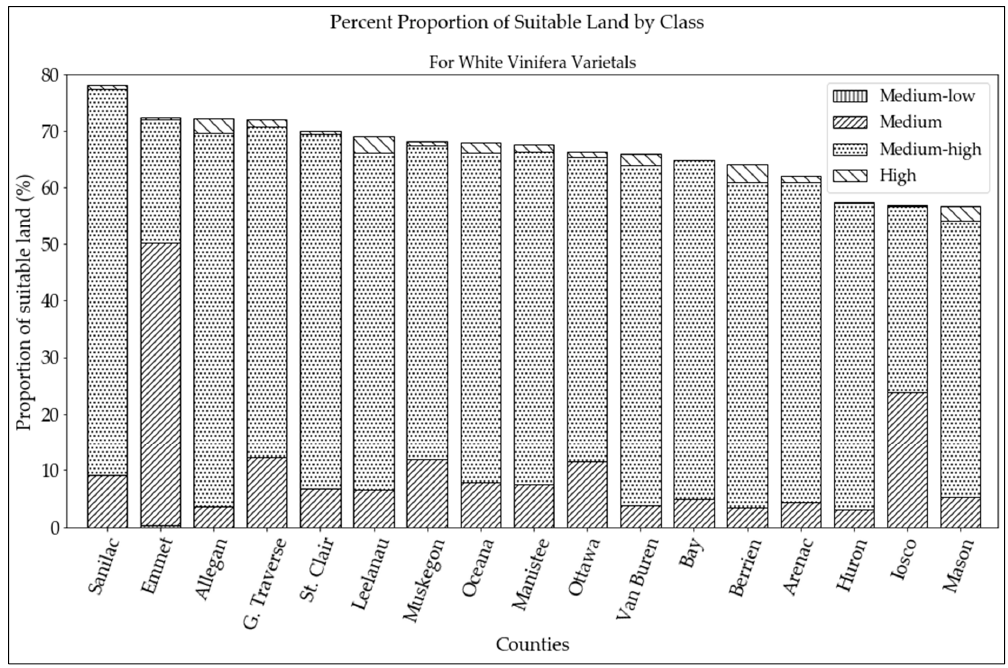
Figure 9. Distribution of land suitability for white vinifera varietals by class. Note that medium-low suitability class is not visible because of the small proportion of land in this class. Note: G. Traverse is Grand Traverse.